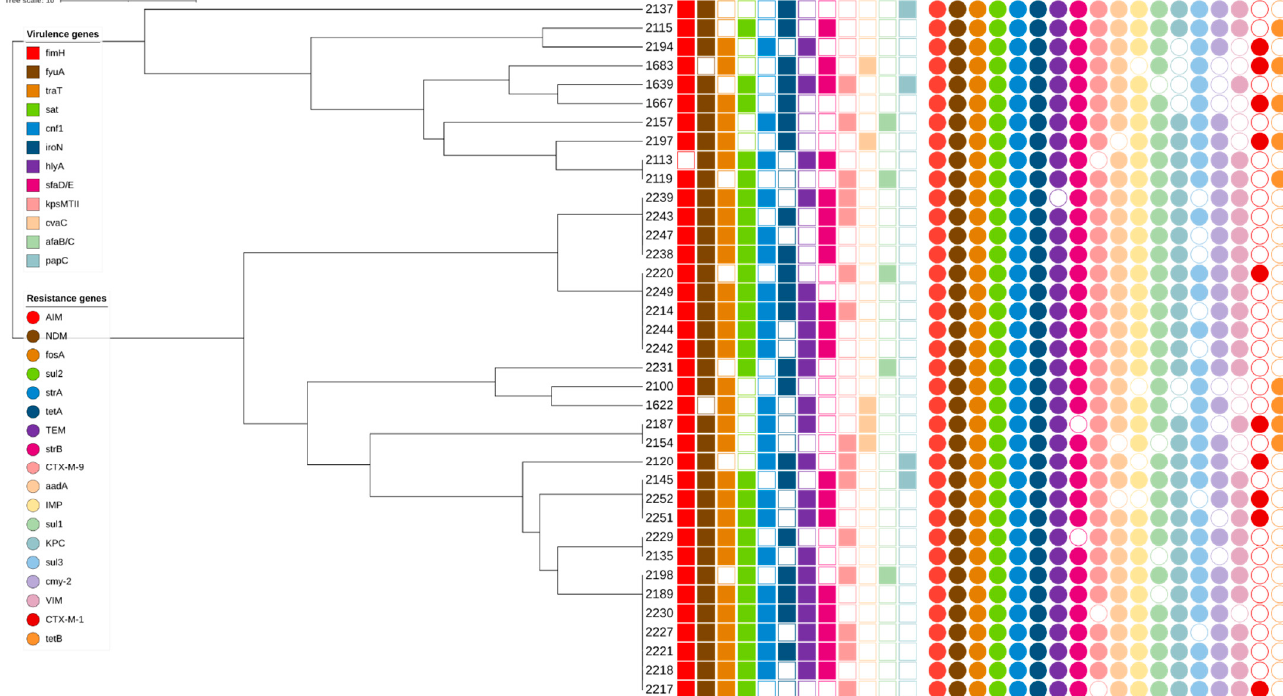
Figure 1. (GTG)5-PCR dendrogram.